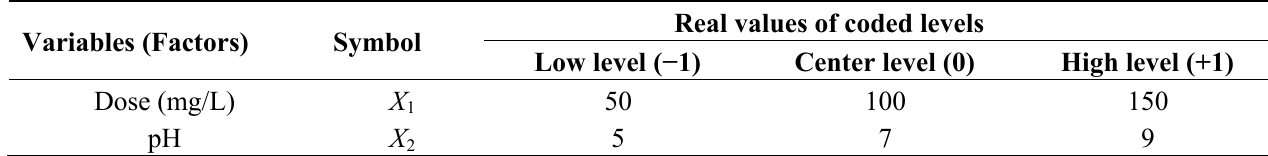
Table 1. Experimental factor levels for independent